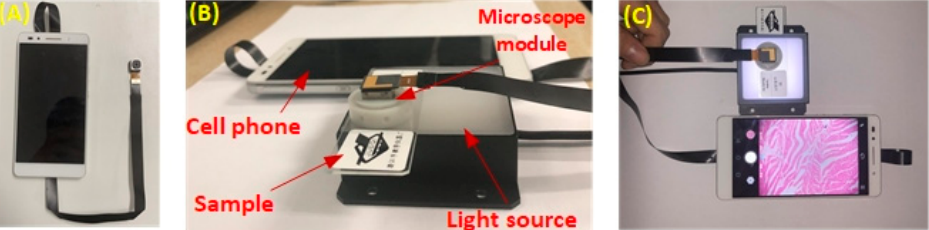
Figure 4. Fabricated miniature cell phone microscope. ( A ) After modification, the cell phone camera can be led out of the cell phone by a flexible cable. ( B , C ) Image of the miniature microscope configuration and working scene.